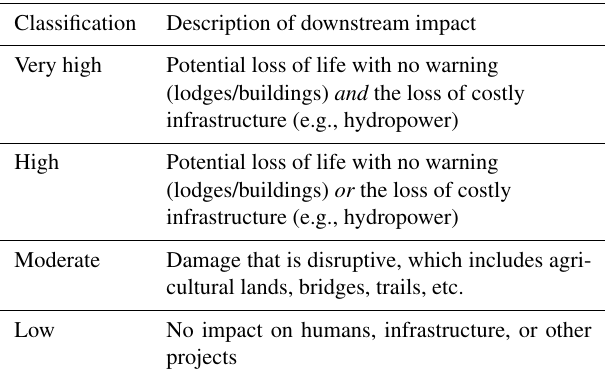
Table 4. Descriptions of downstream impact classifications.